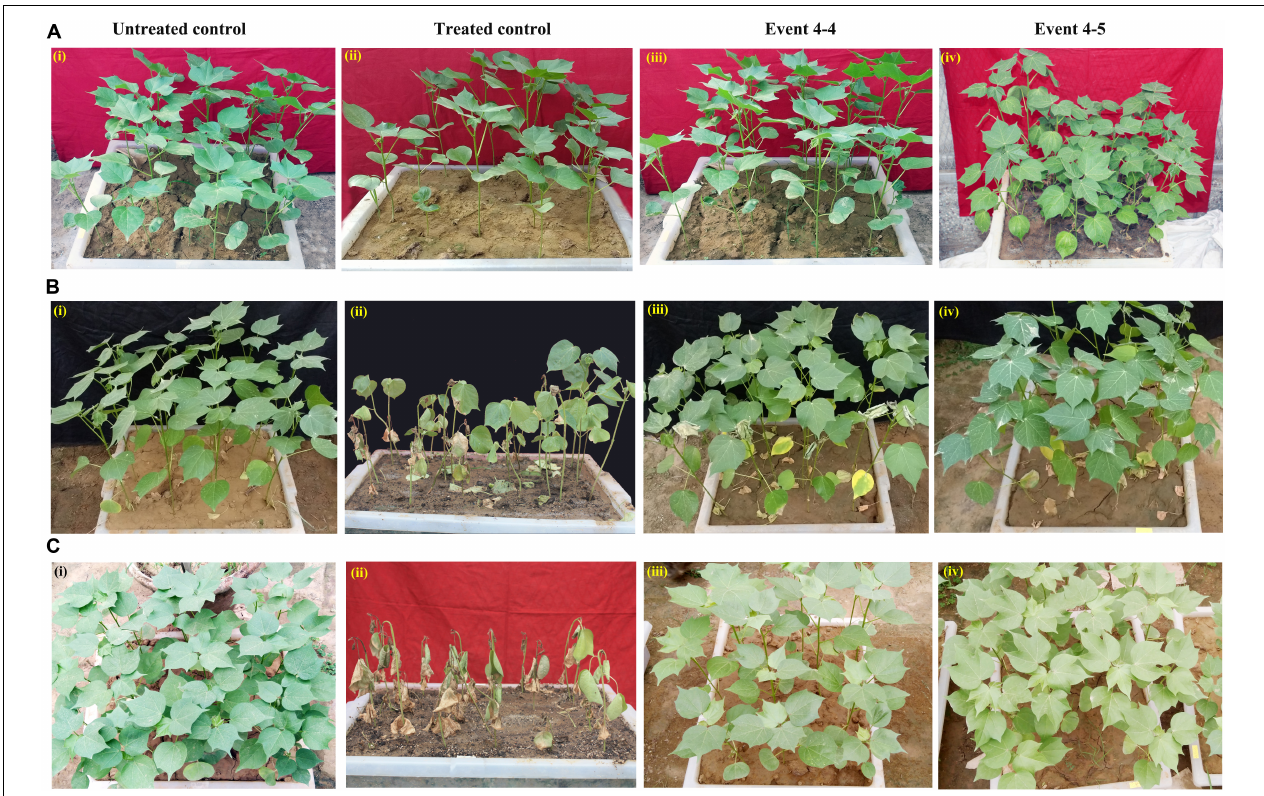
FIGURE 5 | Glyphosate tolerance assay to assess inheritance in T2 generation. (A) Wild-type [ (i) untreated control, (ii) treated control] and selected T2 generation transgenic cotton plants [ (iii) Event 4-4, (iv) Event 4-5] maintained under greenhouse conditions. (B) Response of transgenic plants vis-à-vis wild-type to